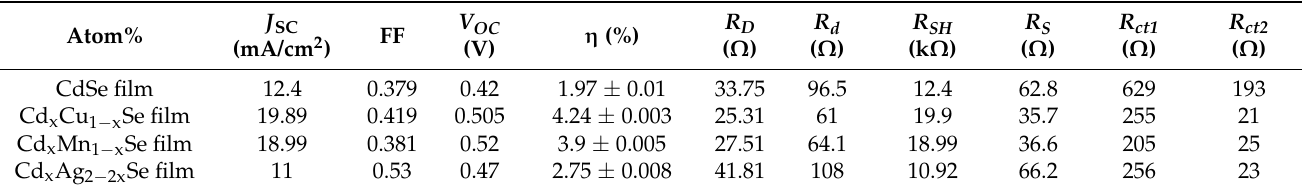
Table 2. The values of the performance efficiency (efficiency, short-circuit current, open-circuit voltage, fill factor) and R D , R d , R SH , R s were estimated from J-V curves and R ct1 , R ct2 were obtained from the EIS experiment. Atom% J SC (mA/cm 2 )